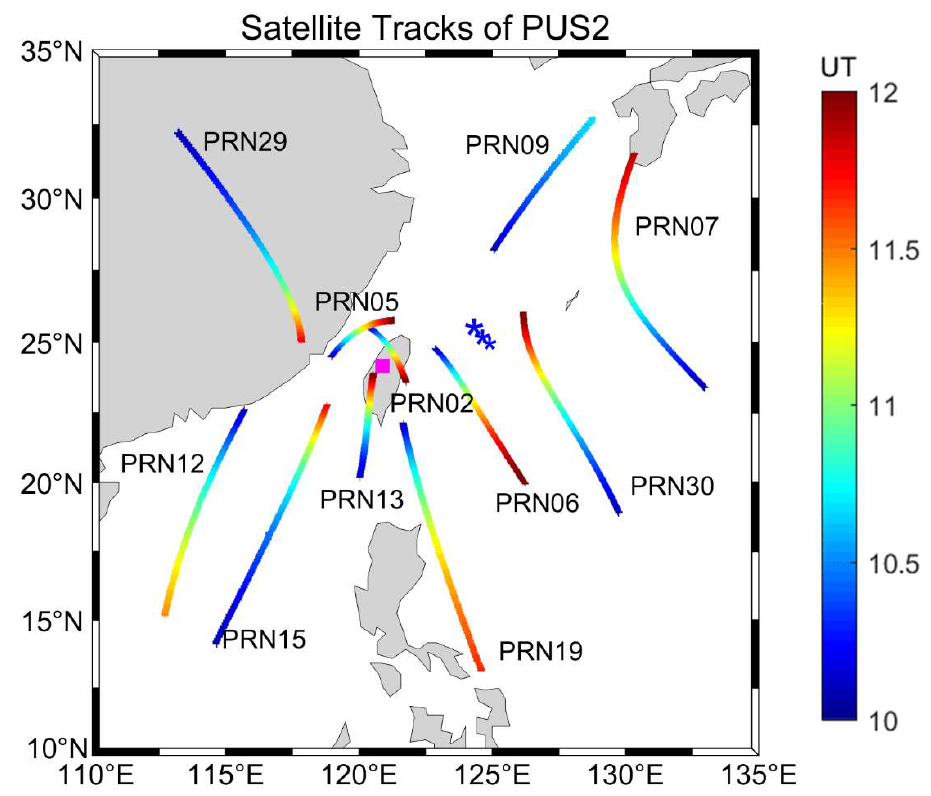
Figure 3. Sub-ionospheric point (SIP) trajectory observed over station PUS2 during the period of 10–12 UTC, 10 July 2018. The blue asterisk indicates the typhoon eye, the magenta square is the location of station PUS2, and the color bar shows the time of the typhoon change.